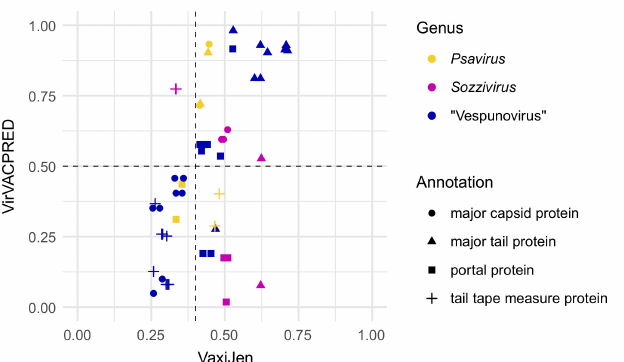
Figure 6. Probability of immunogenic potential of bacteriophage structural proteins in “Vespunovirus”, Psavirus, and Sozzivirus members. The thresholds for probability values are shown as dashed lines. The proteins were homologous within the genera, but not between the genera. The plot was visualized in ggplot2 3.3.5 package [62] for R 4.1.2